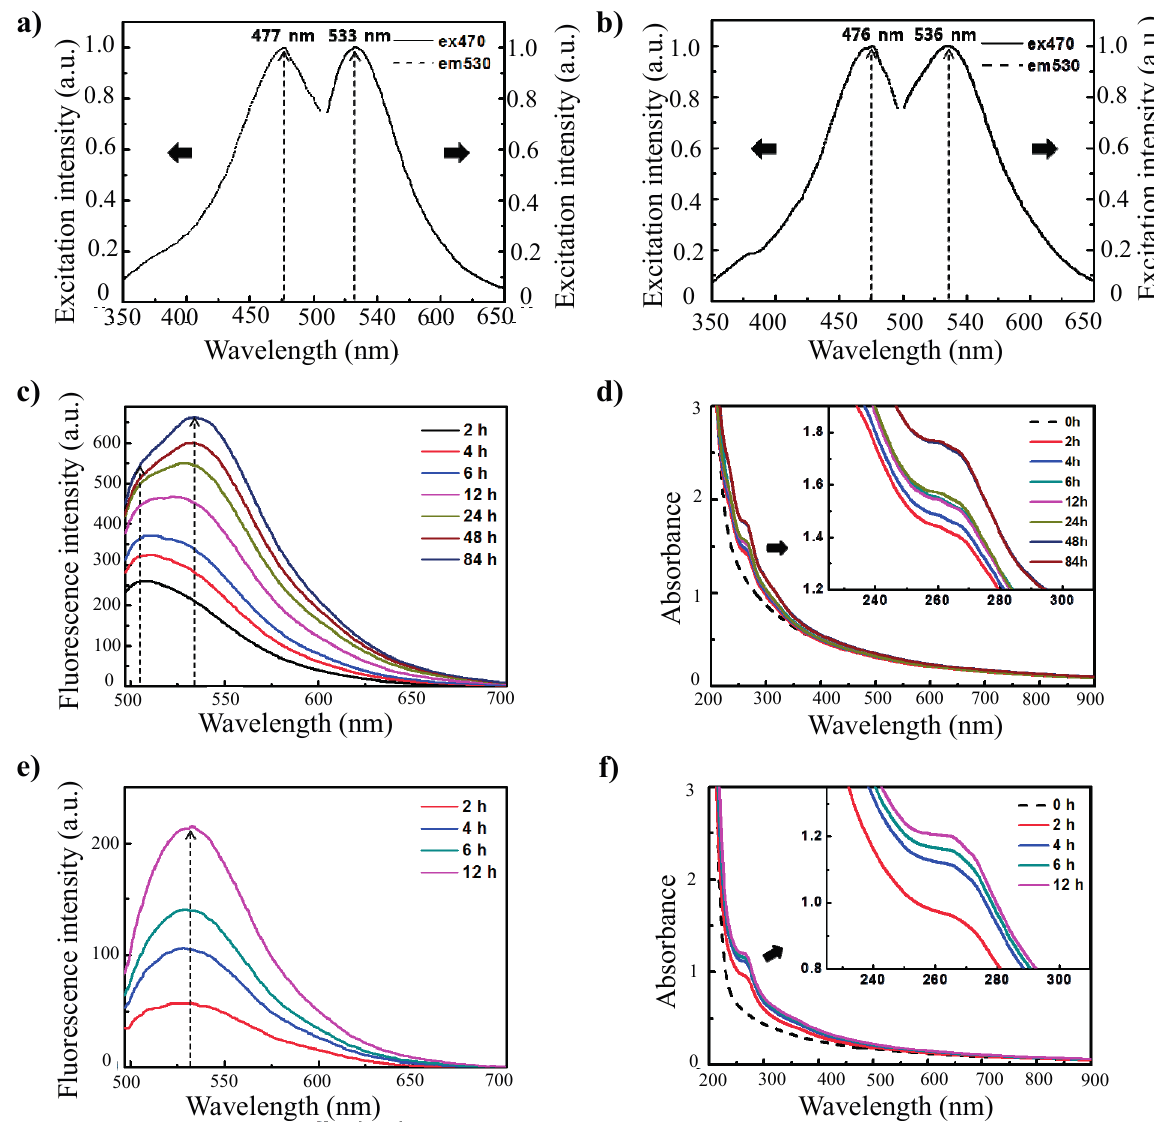
Figure 2. ( a ) Fluorescence excitation ( λ em: 530 nm) and emission ( λ ex: 470 nm) curves of γ -PGA/PLL cross-linked with glutaraldehyde for 12 h; ( b ) Fluorescence excitation ( λ em: 530 nm) and emission ( λ ex: 470 nm) curves of γ -PGA/Chitosan cross-linked with glutaraldehyde for 96 h; ( c ) Fluorescence emission spectra and ( d ) UV-vis spectra of γ -PGA/Chitosan cross-linked with 10 μ L glutaraldehyde for different times ( λ ex: 470 nm). ( e ) Fluorescence emission spectra and ( f ) UV-vis spectra of γ -PGA/PLL cross-linked with 10 μ L glutaraldehyde for different times ( λ ex: 470